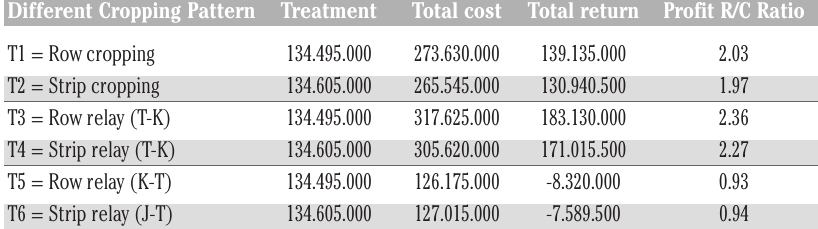
Table 4. Land equity ratio on different cropping treatment. Treatment on